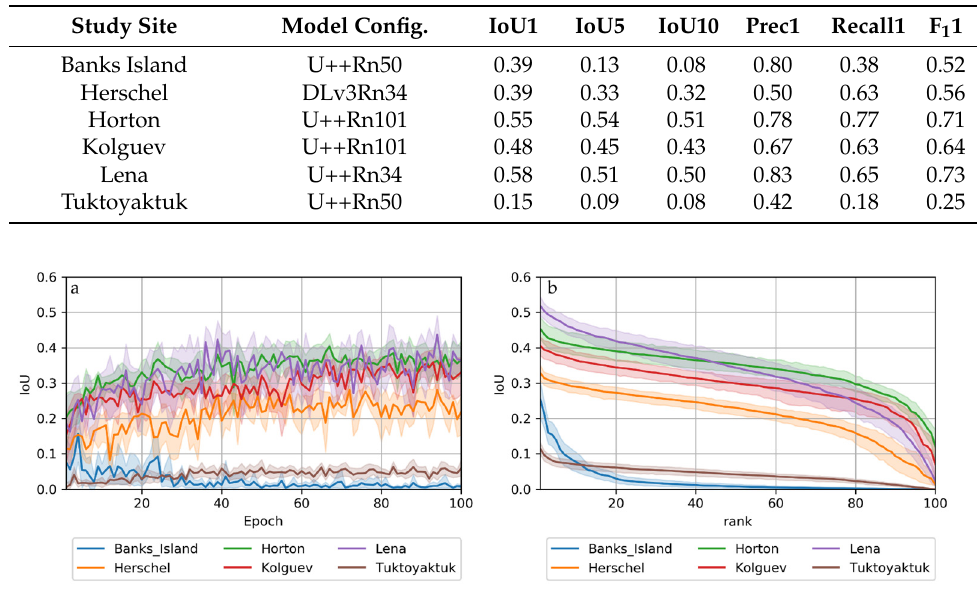
Study Site Model Config. IoU1